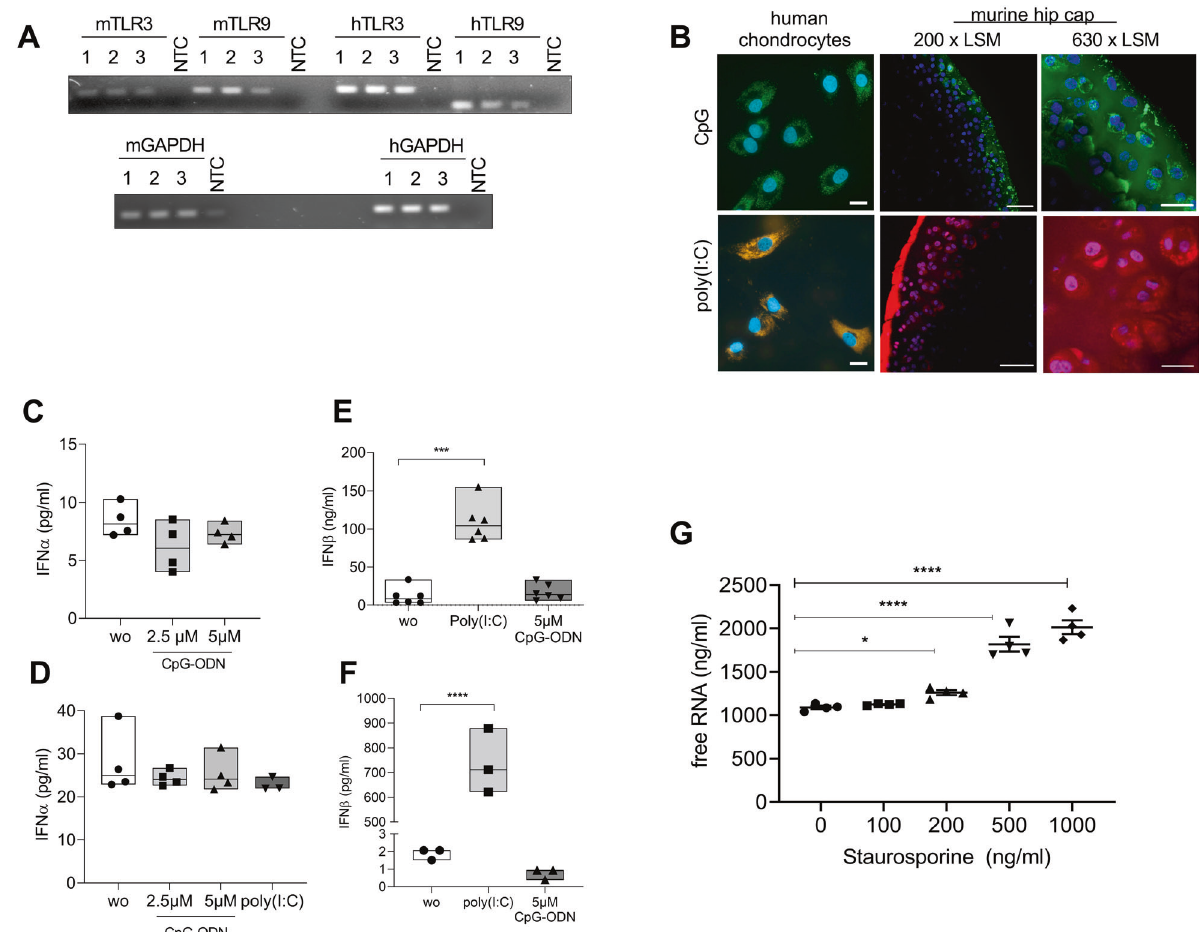
Fig. 1 TLRs are expressed and functional in chondrocytes. A RT-PCR for TLR3 and 9 expression in primary human and murine chondrocytes. GAPDH served as loading control. B Confocal microscopy of labelled CpG (green) and poly(I:C) (red) uptake by either primary human chondrocytes (scale bar 20 µm) or murine hip caps (scale bar 50 µm (centre) 20 µm (right)). DAPI (blue) was used as counterstaining for nuclei. C IFN α ELISA of murine chondrocytes stimulated with ODN (one-way ANOVA:F (2, 9) = 2.21, p = 0.16, N = 4). D IFN α ELISA of primary human chondrocytes stimulated with ODN and poly(I:C) (one-way ANOVA:F (3, 11) = 0.75, p = 0.55, N = 4). E IFN β ELISA of murine chondrocytes stimulated with poly(I:C) or ODN (one-way ANOVA: F (2, 15) = 59.61, p < 0.0001, N = 6). F IFN β ELISA of primary human chondrocytes stimulated with poly(I:C) or ODN (one-way ANOVA:F (2, 6) = 95.43, p = <0.0001, N = 3). G Staurosporine was used to induce cell death. The release of RNA from human primary chondrocytes after treatment was measured in the culture supernatant using the RiboGreen assay